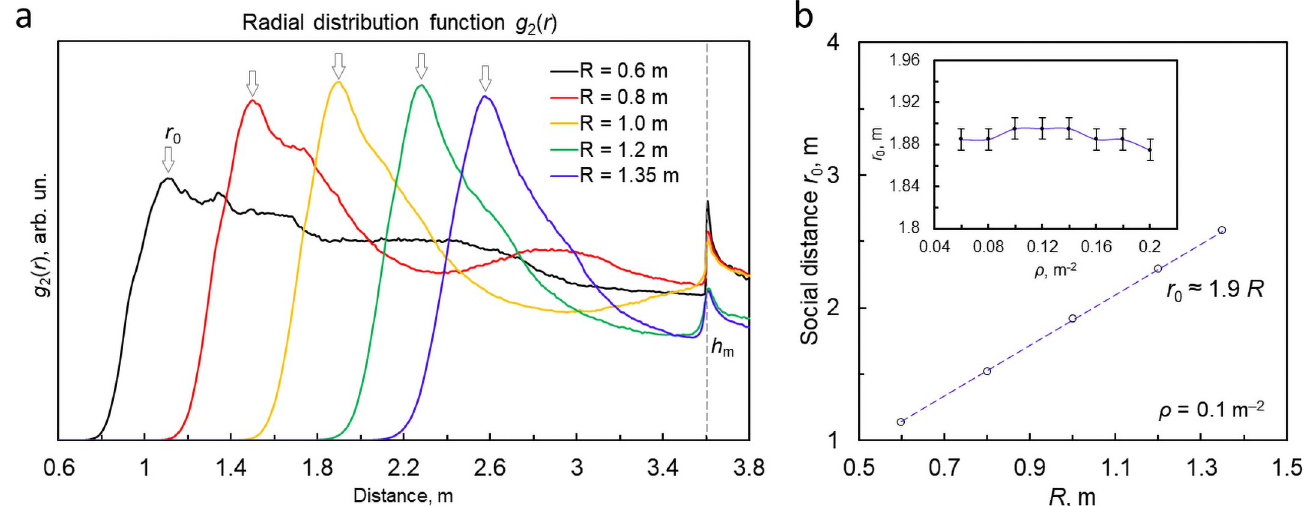
Fig 3. The distribution of inter-customer distances specified by the radial distribution function g 2 ( r ) for different social radii R . (a) The g 2 ( r ) for the typical density ρ = 0.1 m − 2 ; h m indicates the passage width. (b) The dependence of the peak location r 0 (indicated in panel (a)) on R . The least square fit gives r 0 ’ 1.9 R for ρ = 0.1 m − 2 . With increasing density ρ the peak location slightly shifts towards smaller distances, which may be neglected for the addressed range of parameters (see the